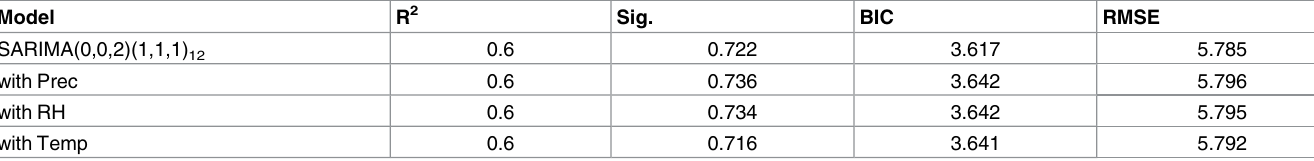
Table 3. Multivariate SARIMA model integrating meteorological variables. Model R